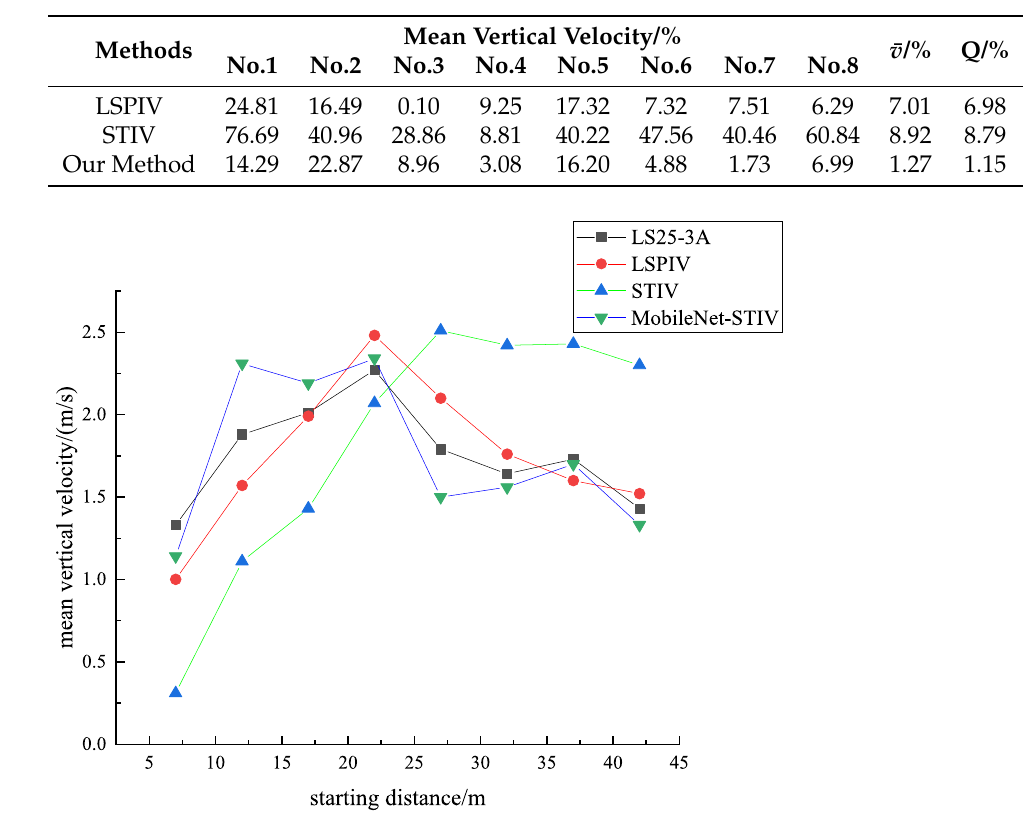
Figure 17. Comparison of mean vertical flow